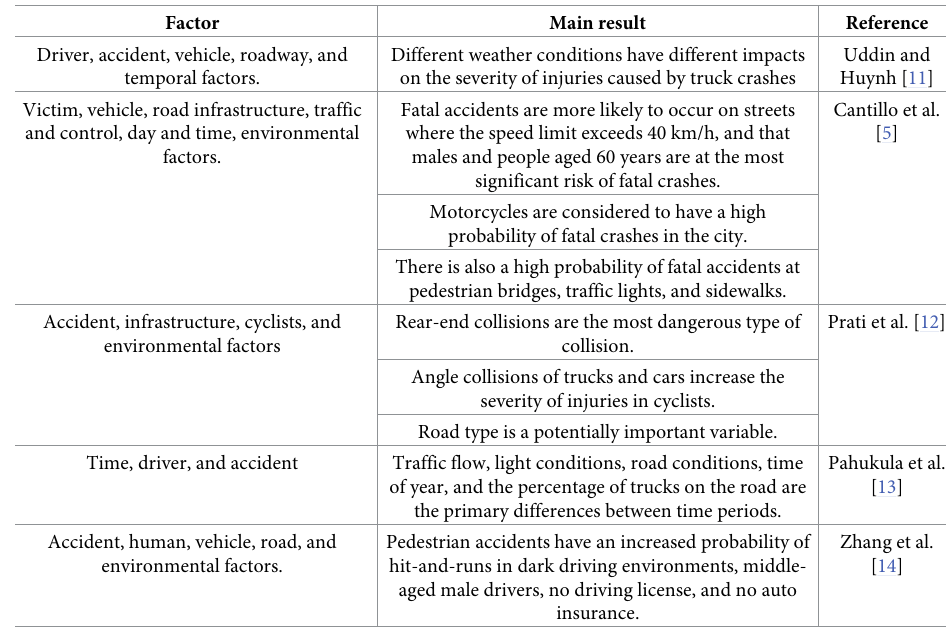
Table 1. Studies on factors related to road